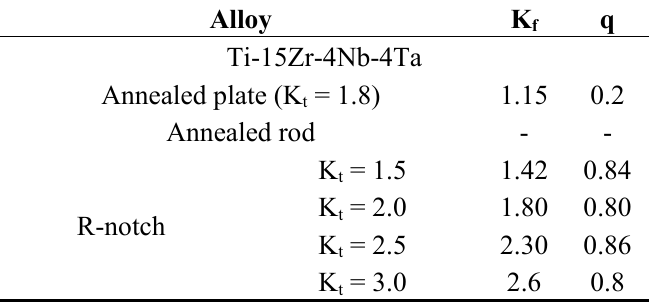
Table 4. Comparison of fatigue notch factor (K cycles among